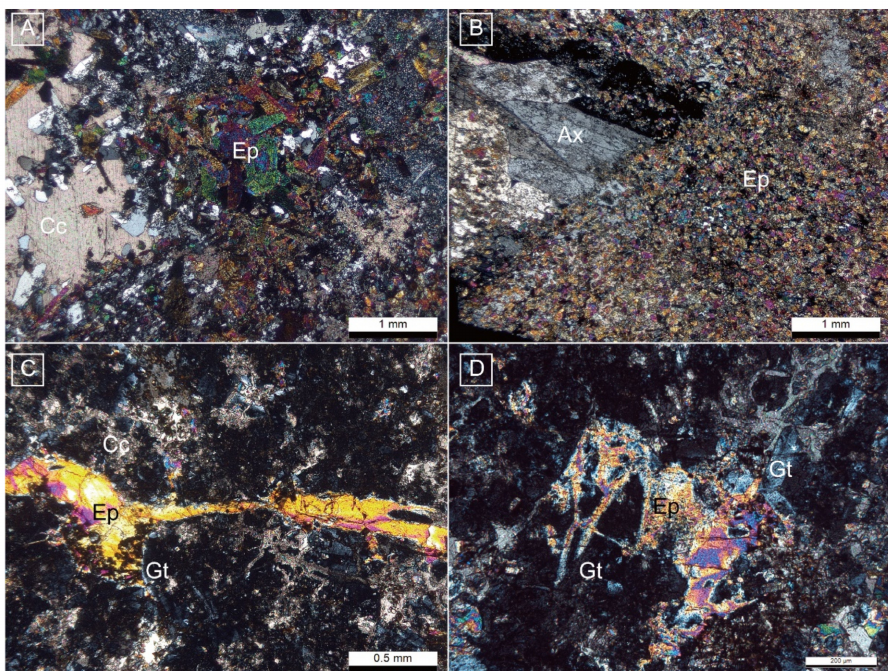
Figure 11. Microphotographs of the epidote skarn ( A , B ) and the garnet skarn ( C , D ). All the photos are under crossed nicols. ( A ) Thin and prismatic epidote (Ep) replaces calcite (Cc). ( B ) Small crystals of epidote aggregate (Ep) cross-cut axe-head shaped axinite (Ax). ( C , D ) Epidote (Ep) veinlet in the garnet skarn, composed mainly of garnet and calcite